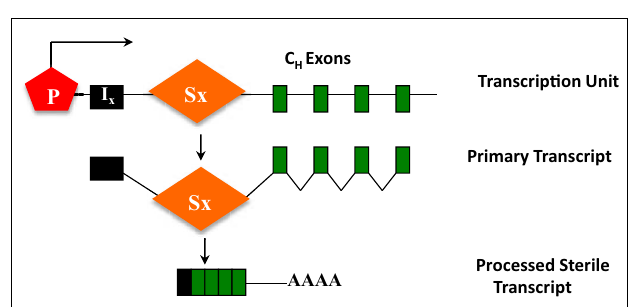
FIGURE 5 | C H exons as transcription units . Each set of C H exons is an independent transcription unit comprised of a promoter (P), an intervening I-exon, an intronic-switch (S) region, and C H exons.The primary transcript is spliced and polyadenylated but does not have protein-coding capacity, and is thus referred to as a sterile